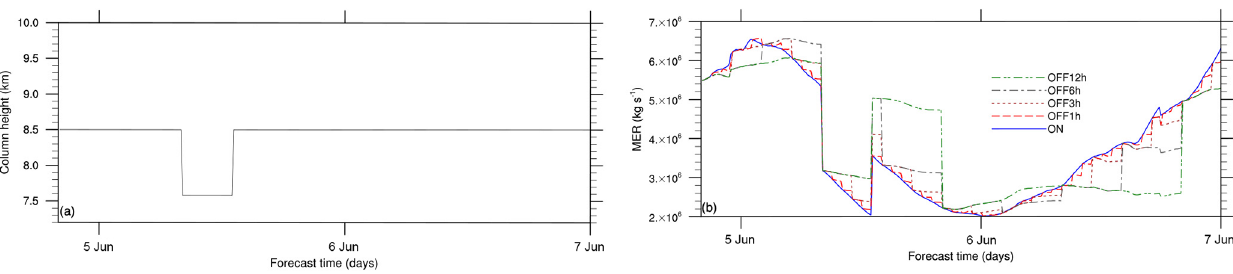
Figure 10. Eruption source parameters for the 2011 Cordón Caulle case: (a) column height fluctuation over time. (b) Resulting MER over time for each coupling strategy (meteorology coupled online or with intervals of time of 1, 3, 6, and 12h).